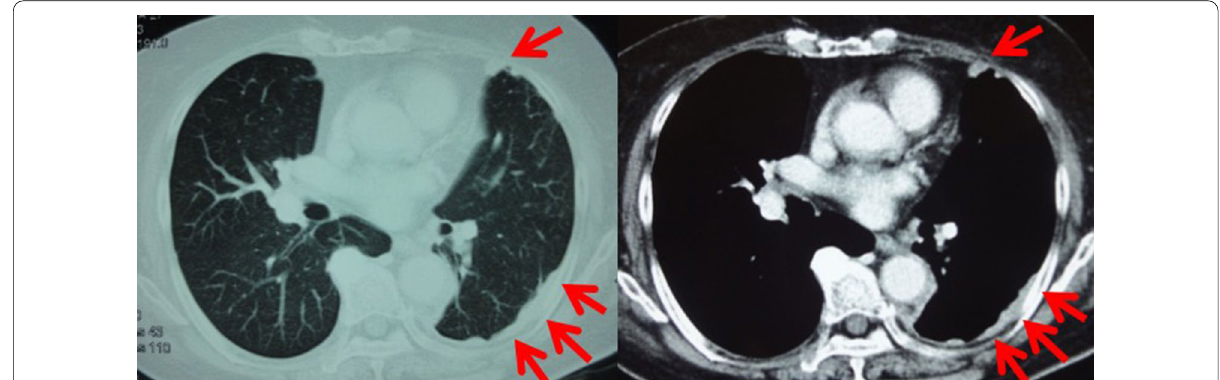
Fig. 4 Pleural metastasis was observed in the postoperative chest CT scan. Arrows (